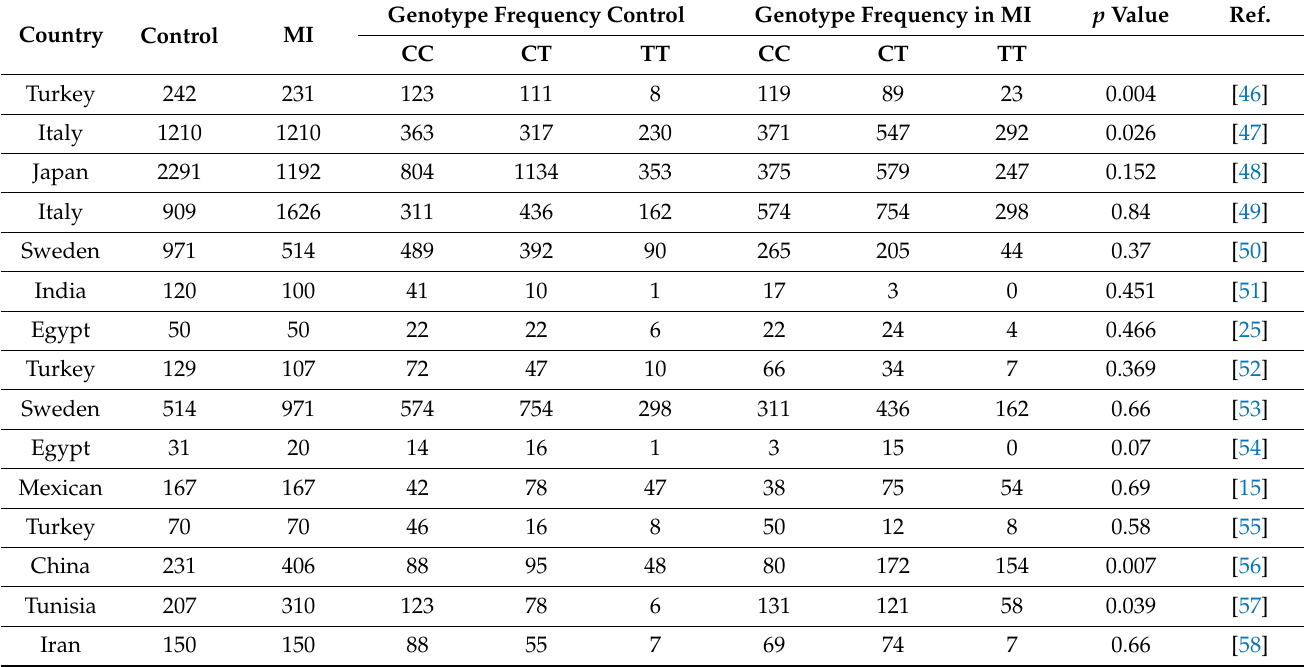
Table 10. Studies showing the association between MTHFR C677T polymorphism and myocardial